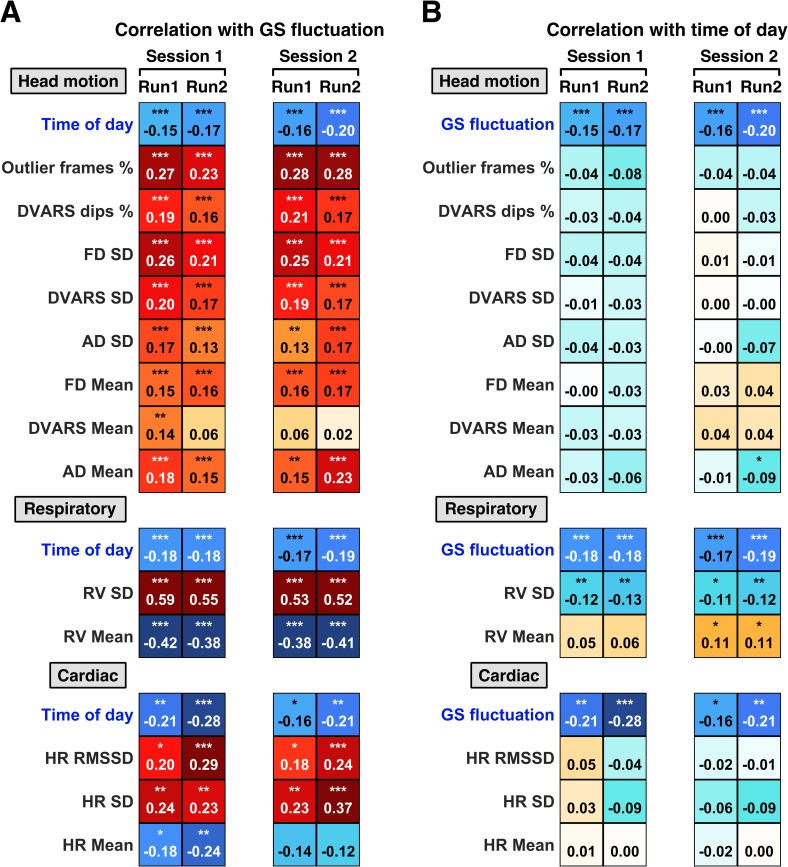
Head motion, respiratory, and cardiac measures are strongly correlated with GS fluctuation, yet only respiratory variation shows association with time of day.(A) Between-participant correlations of 13 run-level summary metrics with GS fluctuation. (B) Between-participant correlations of 13 run-level summary metrics with time of day. Because of exclusion of individuals with poor physiological data quality, different subgroups of participants were used for analyses of head motion (session 1: N = 942, session 2: N = 869), respiratory (session 1: N = 741, session 2: N = 668), and cardiac measures (session 1: N = 273, session 2: N = 272). Correlation between GS fluctuation and time of day was repeated in each subgroup. Numbers denote Pearson correlation coefficients. Stars indicate significant correlations following FDR correction (*q < 0.05; **q < 0.01; ***q < 0.001). See S2 Data for underlying data. AD SD, standard deviation of absolute displacement; DVARS SD, standard deviation of the temporal derivative of root mean square variance over voxels; FD SD, standard deviation of framewise displacement; FDR, false discovery rate; GS, global signal; HR RMSSD, root mean of the successive differences of heart rate; HR SD, standard deviation of instantaneous heart rate; RV SD, standard deviation of respiratory variation.